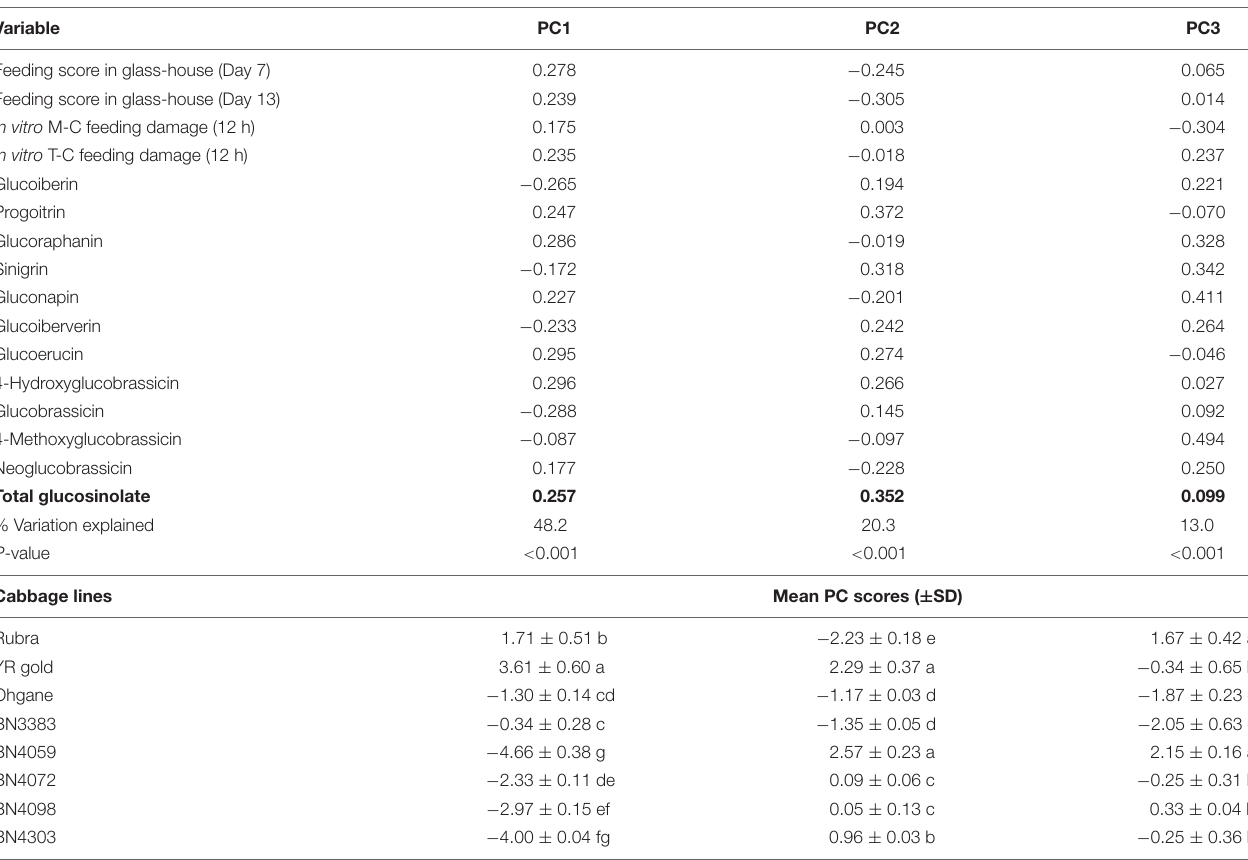
TABLE 1 | Component loadings of glass house- and in vitro- feeding tests; glucosinolate concentrations and mean PC scores of eight cabbage genotypes as determined by the principle component analysis